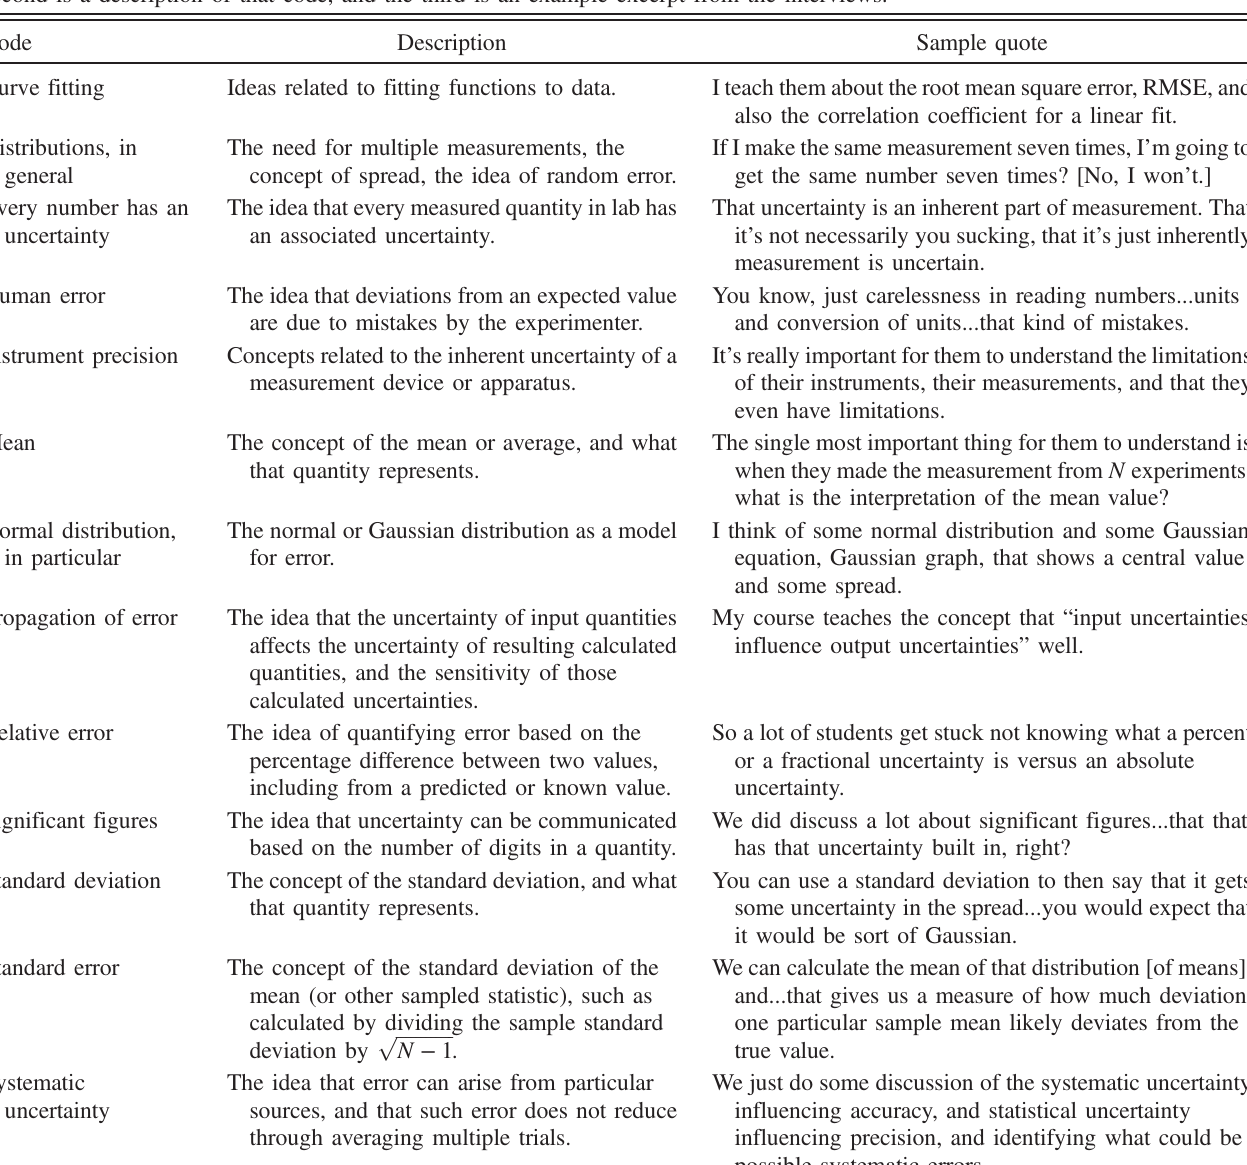
TABLE IV. The set of emergent codes pertaining to measurement uncertainty concepts. The first column is the name of the code, the second is a description of that code, and the third is an example excerpt from the